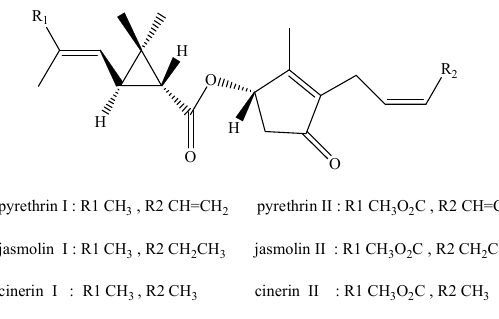
Figure 1. The chemical structures of pyrethrins.